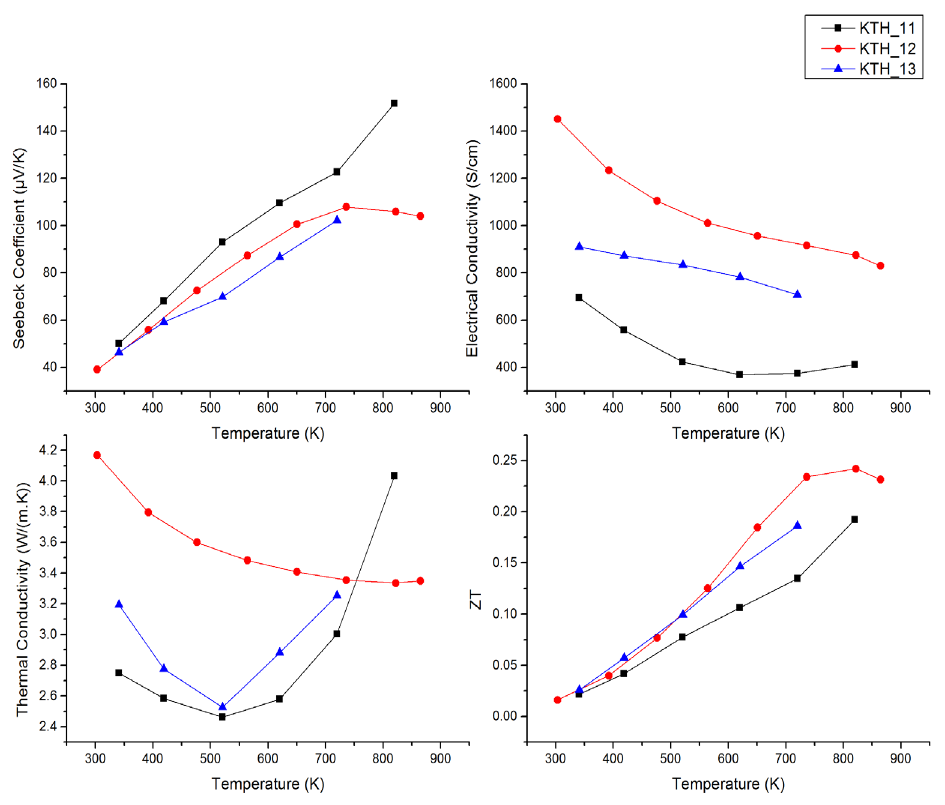
Figure 6: Thermoelectric evaluations of SPS’d KTH samples (as detailed in Table